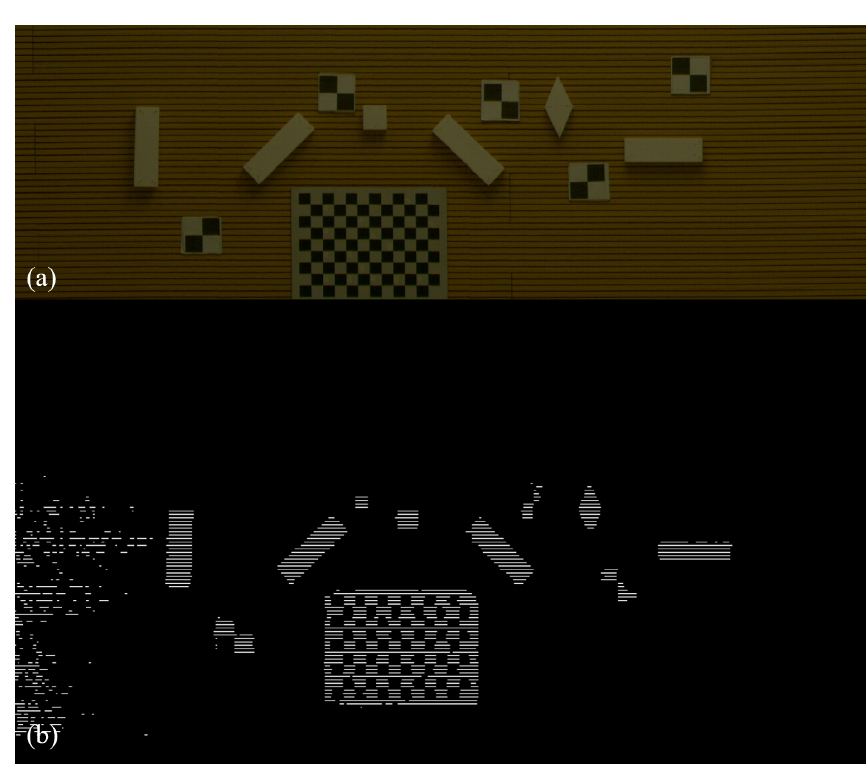
Figure 11. Simulated images of the ( a ) line array and ( b )